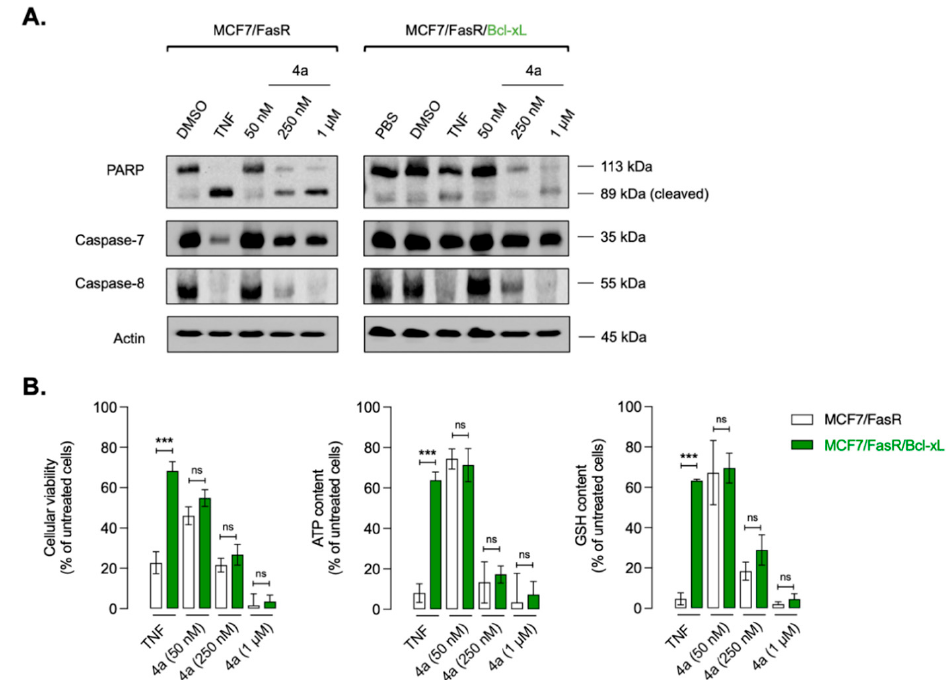
Figure 13. Evaluation of apoptotic biomarkers. MCF7/FasR and MCF7/FasR/Bcl-xL cells were irradiated at 458 nm in presence of the indicated concentration of complex 4a or treated with 100 n/mL TNF α for 72 h. ( A ) Cytosolic extracts from MCF7/FasR and MCF7/FasR/Bcl-xL cells were separated by SDS-PAGE and probed with anti-PARP, anti-caspase-7 and anti-caspase-8. Migrations indicated are: full-length PARP p113, cleaved PARP p89, full-length caspase-7 and full-length caspase-8. ( B ) MTT, ATP and GSH assays were evaluated in duplicate samples. Data are expressed as percent (%) of untreated cells and are the means of 3 independent experiments (***, p < 0.0001, NS, not